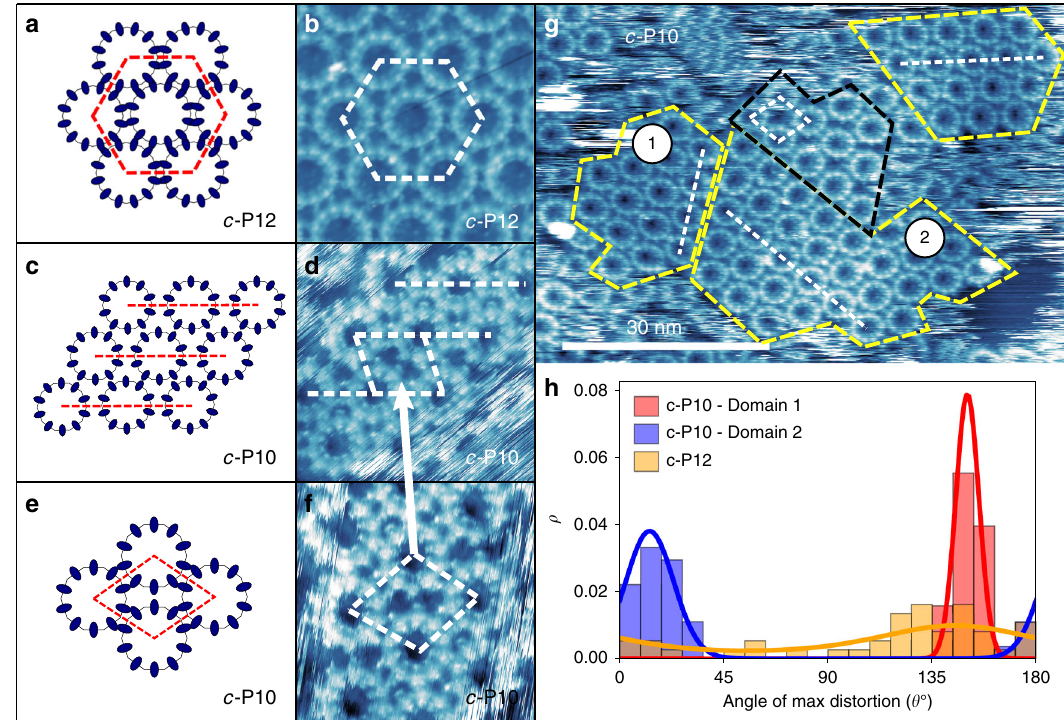
Fig. 3 Scanning tunnelling microscopy (STM) images showing the arrangement of c- P10 and c- P12 nanorings on highly oriented pyrolytic graphite (HOPG). a Schematic showing the hexagonal packing arrangement observed for c- P12. b STM image of c- P12 hexagonal packing. c Schematic showing the relative orientation of porphyrin groups in the row packing phase for c- P10. d STM image of c- P10 row-like packing connected by a single unit cell of the rhombic phase shown in f and indicated by the white arrow. e Schematic of c- P10 rhombic phase. f STM image of c- P10 rhombic packing connecting two domains of the row phase shown in d . The white dashed lines in images b , d , f indicate the direction of double porphyrin-pair alignment shown by the red dashed lines in the schematic images a , c , e . g STM image of multiple c- P10 domains on HOPG showing regions with row (yellow outline) and rhombic (black outline) packing arrangements. The dashed white lines indicate the directions of double porphyrin – porphyrin alignment shown for both the row and rhombic arrangements. h Histograms showing the direction of maximum distortion of the c- P12 domain shown in Fig. 2b (orange) and the two labelled c- P10 domains in Fig. 3g (red and blue). The solid lines are fi ts to the data using a von Mises distribution of the circular mean and standard deviation